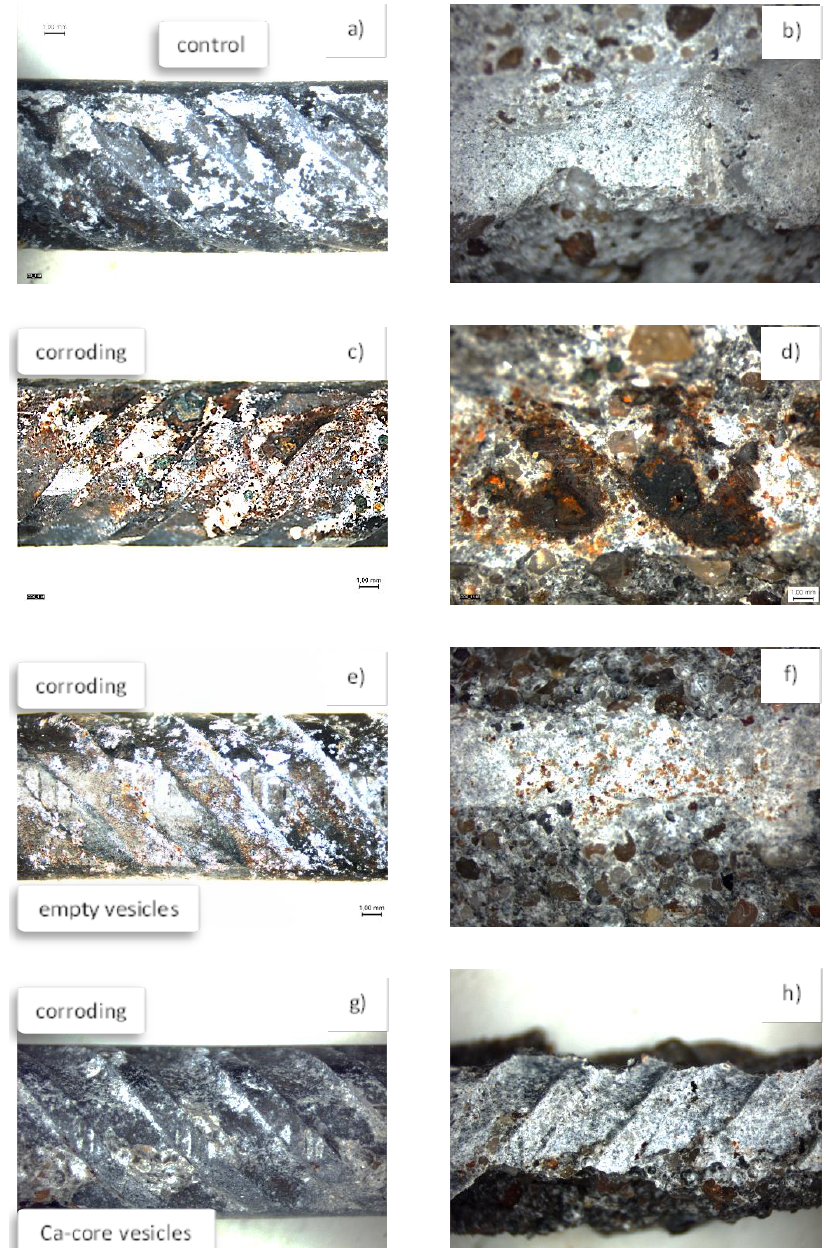
Figure 7. Light microscopy of the steel reinforcement (left column) and the corresponding “print” in the cement paste (i.e., adjacent bulk matrix) for control and corroding, vesicle-free specimens ( a – d ) and corroding, vesicle-containing specimens ( e – h ). The observations were recorded after the specimens were broken open after 300 days of